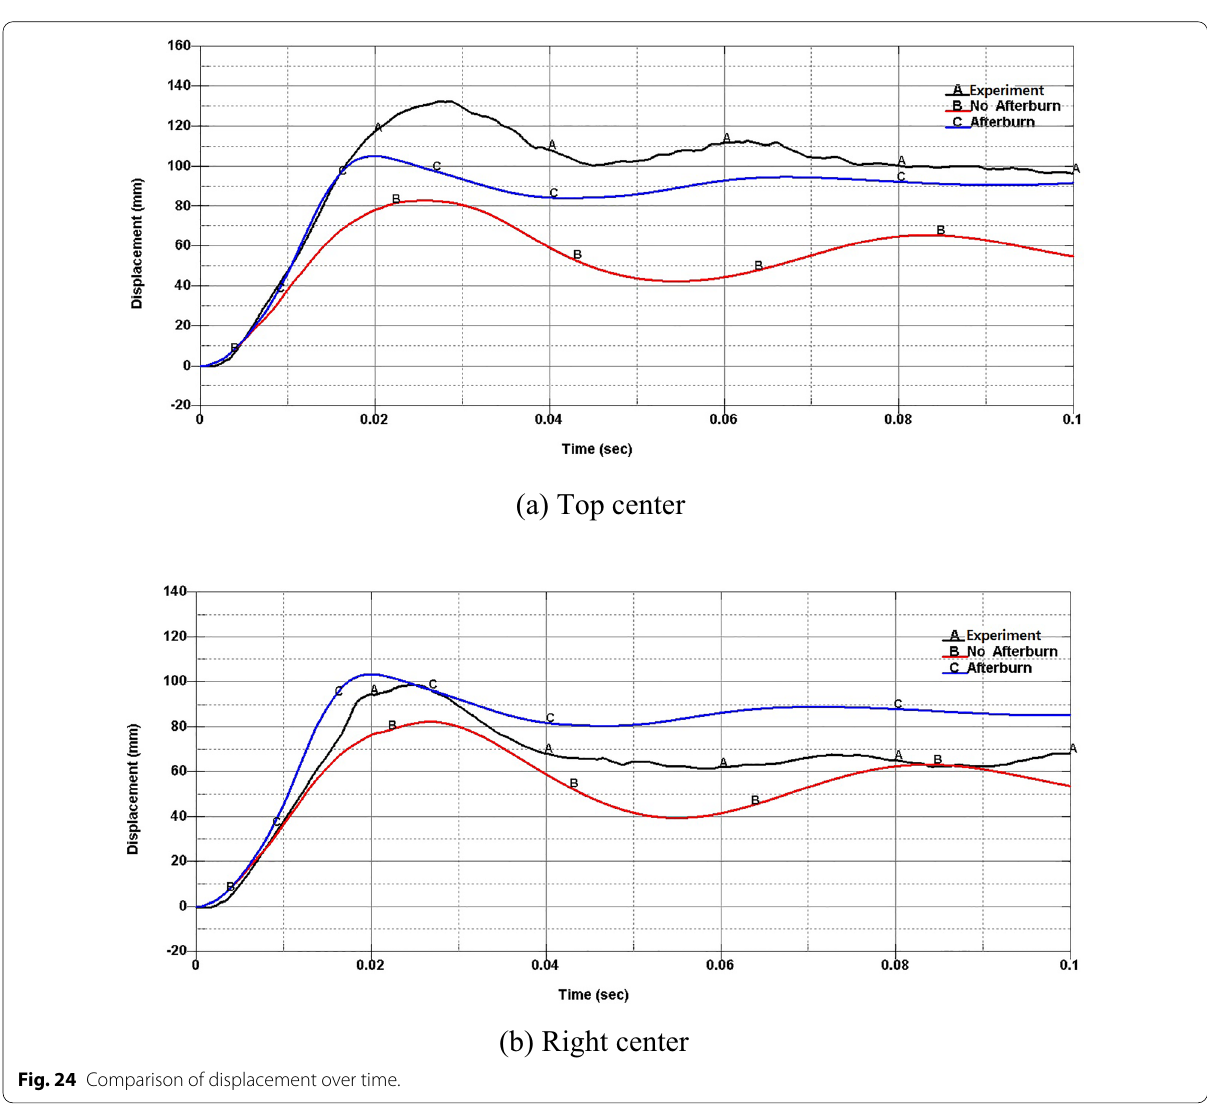
Fig. 24 Comparison of displacement over time.